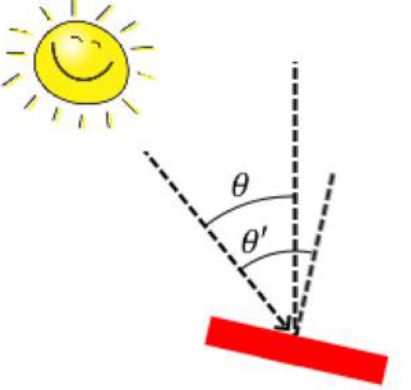
Figure 2 . The solar zenith angle ( 𝜃 ) and solar apparent zenith angle ( 𝜃 ′ ) on a surface of a tilted